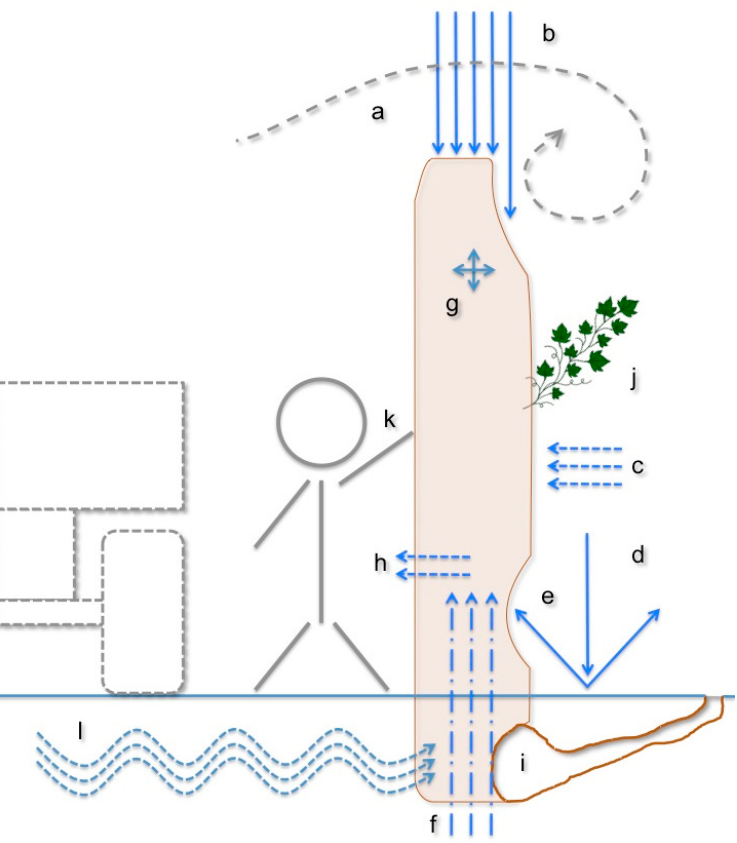
Figure 3. Schematic representation of the decay processes observed in pisé buildings after the roof has been removed/collapsed (see text for explanation). Reprinted from Ref. [9].